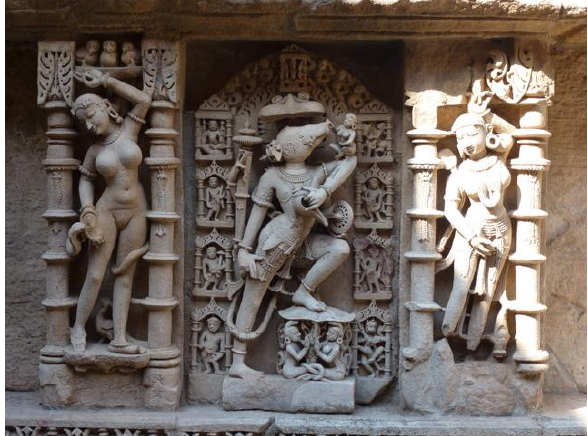
Figure 8. Specially designed rig with laser scanner attached and suspended over centre of well to capture areas not visible from Figure 7. Sculptural detail at Rani ki Vav stepwell, Gujarat, other vantage points © CDDV India © CDDV 2011.